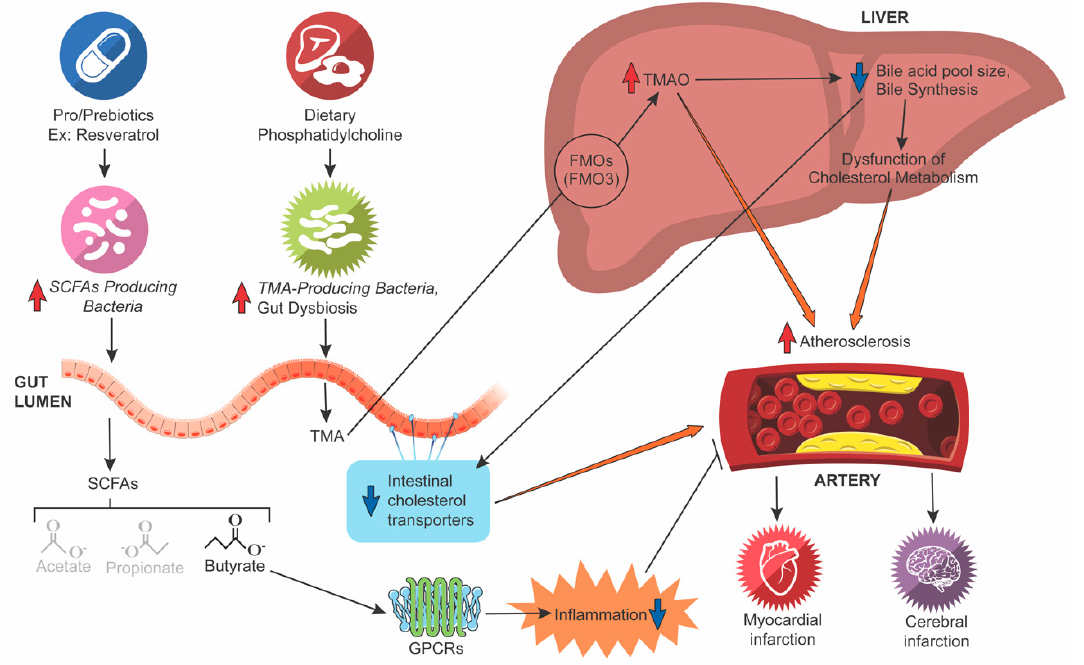
Figure 1. Mechanisms by which microbiota participate in atherosclerosis. The dietary nutrients choline and carnitine are selectively converted into TMA by TMA-producing and metabolizing enzymes from anaerobic gut microbiota. TMA is transferred to the liver via portal circulation and oxidized by the hepatic flavin monooxygenase 3 (FMO3), resulting in the production of TMA–N-oxide (TMAO). Increasing TMAO has been demonstrated to decrease the bile acid pool size and inhibit bile acid synthesis, impacting cholesterol metabolism via altered intestinal cholesterol transport, specifically reverse cholesterol transport (RCT). TMAO has also been associated with enhanced macrophage cholesterol accumulation and atherosclerosis development. Supplementation with pro/prebiotics, such as resveratrol , can increase butyrate-producing bacteria. With the increase in butyrate-producing bacteria, TMA-producing bacteria become less prominent as they are outcompeted for resources. This results in increased levels of butyrate, which binds to G protein-coupled receptors (GPCRs), leading to decreased intestinal inflammation and an overall decreased risk of atherosclerosis, myocardial infarction, and cerebral infarction.